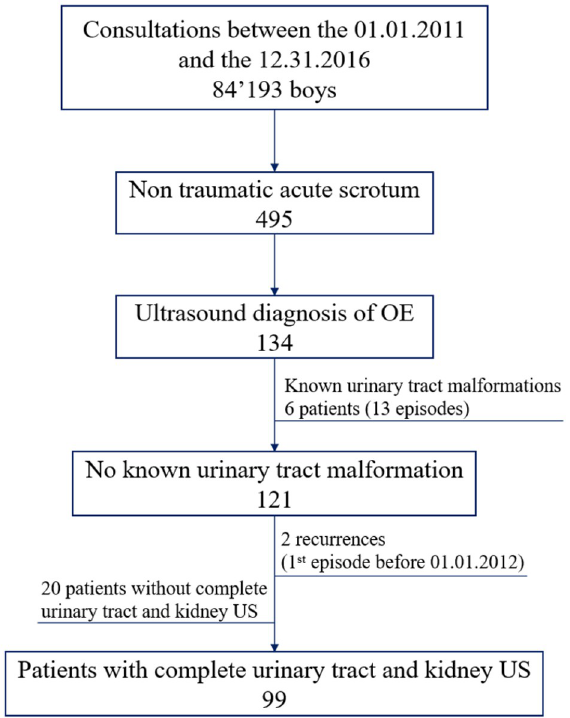
Fig 1. Patient selection flowchart. Patient inclusion and exclusion criteria applied in the study with number of included patients below each criterion.